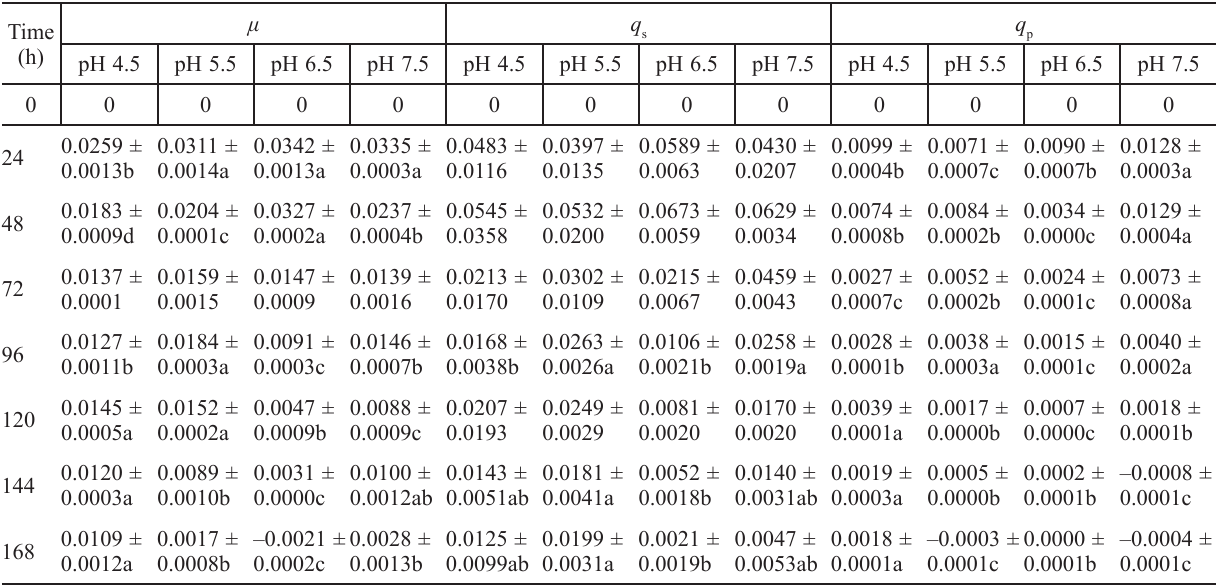
Table 1 – Time course of kinetic parameters on the submerged culture of H. marmoreus in 5-L fermenter under different constant pH a